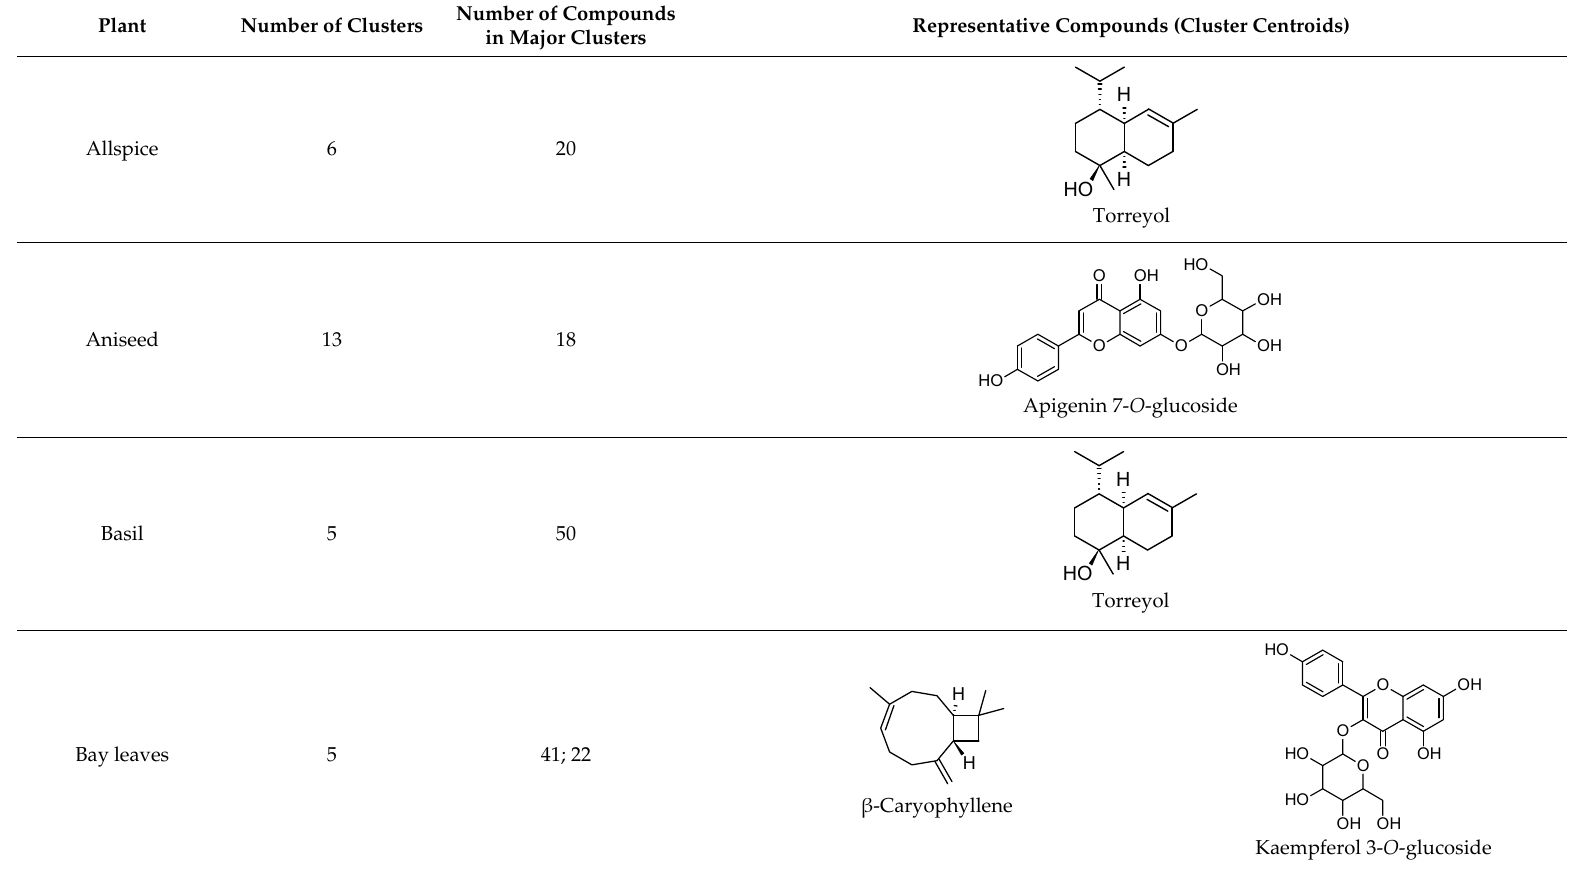
Table 4. Hierarchical clustering analysis of the identified bioactive compounds of various herbs and spices.